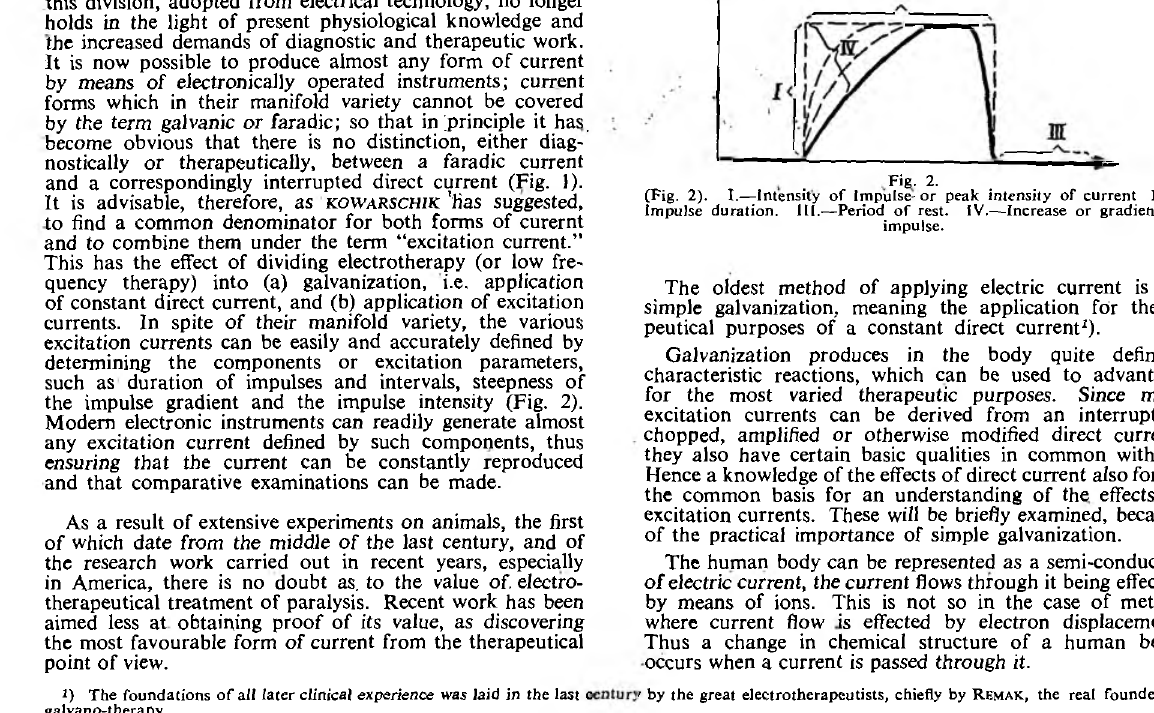
Fig. 2. (Fig. 2). I.—Intensity of Impulse- or peak intensity of current 11.— Impulse duration. III.—Period of rest. IV.—Increase or gradient of